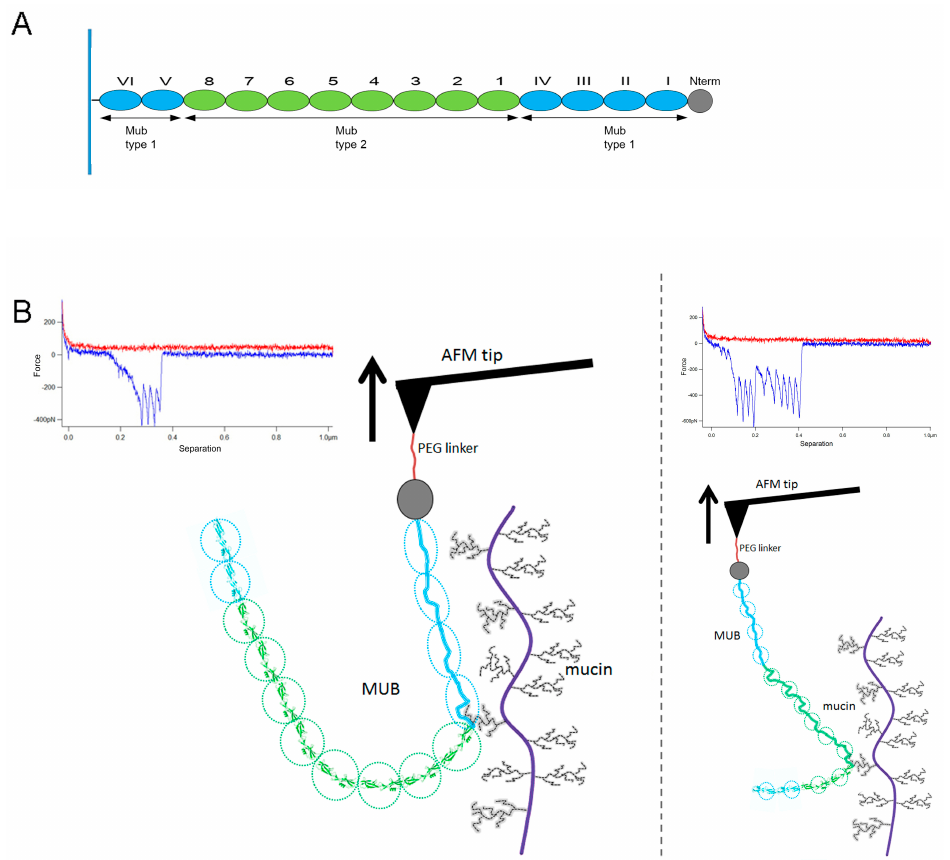
Figure 5. Diagram of the proposed binding scheme. ( A ) Schematic representation of the modular repeat region of MUB from L. reuteri ATCC 53608 ( grey : N-terminal domain; blue: type 1 Mub repeat domains; green: type 2 Mub repeat domains) and ( B ) Schematic diagram representation of the negative peaks in the force curve. Left panel: unfolding of four type 1 Mub repeat domains ( blue ); Right panel: unfolding of four type 1 Mub repeat domains ( blue ) and six type 2 Mub repeat domains ( green ).